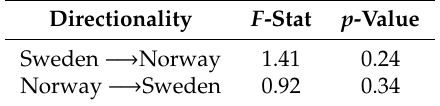
Table 3. Granger causality test for pine sawlogs prices ( k = 2 )